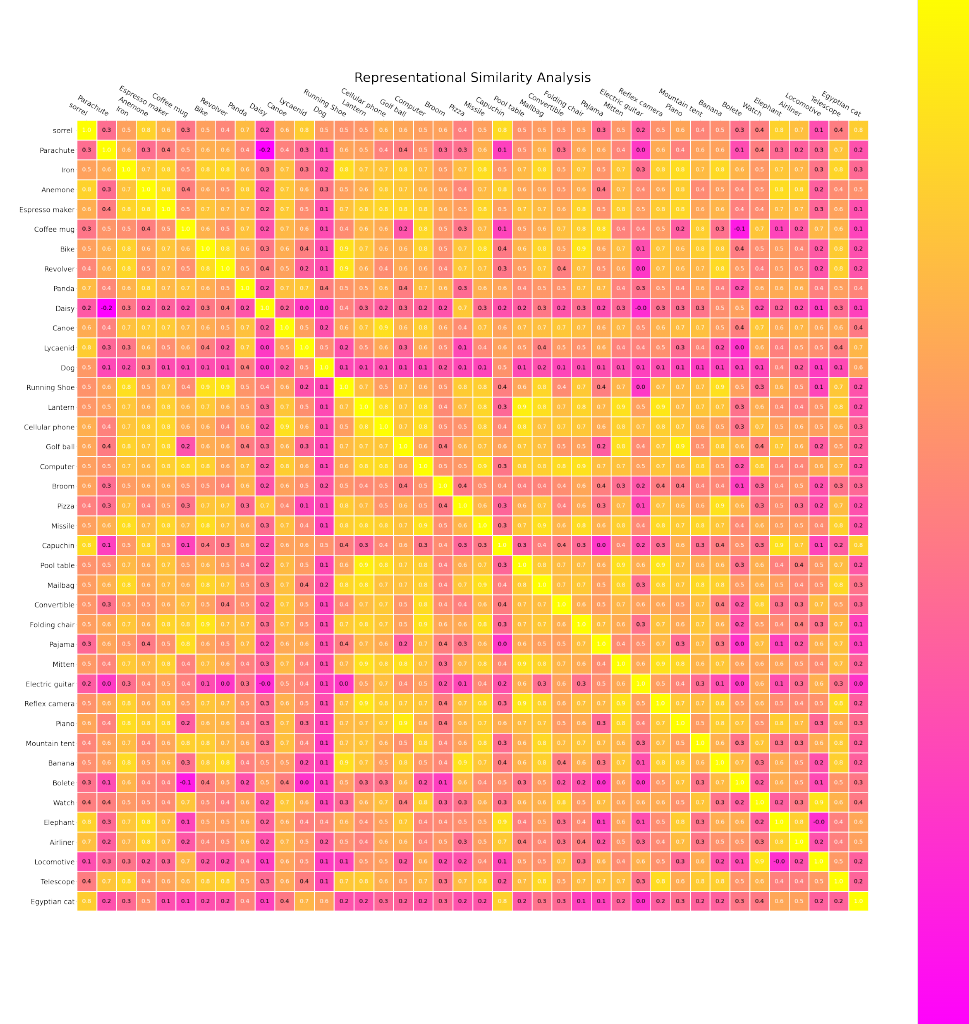
Figure 9. Representational similarity analysis.